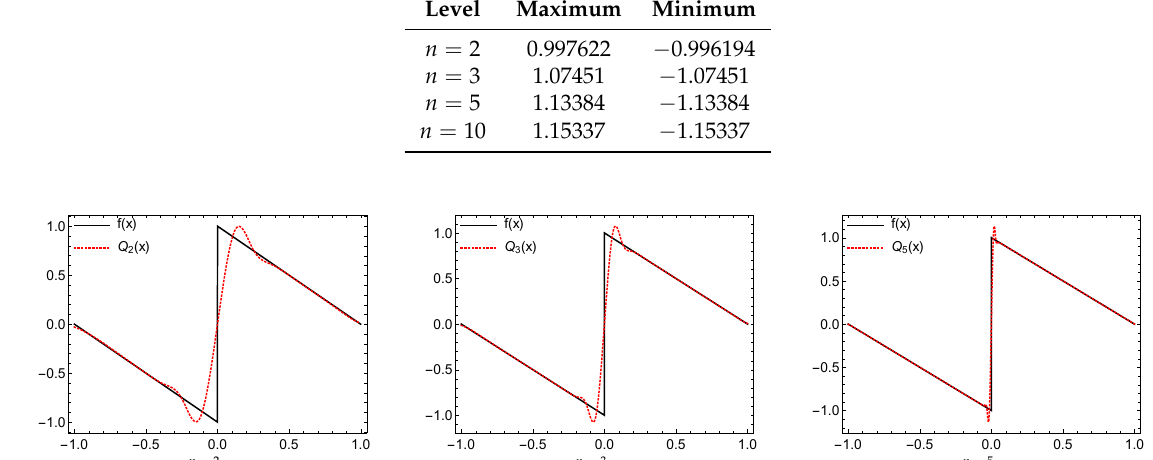
Figure 12. Illustration of the Gibbs effect using the quasi-operator Q n f of Example